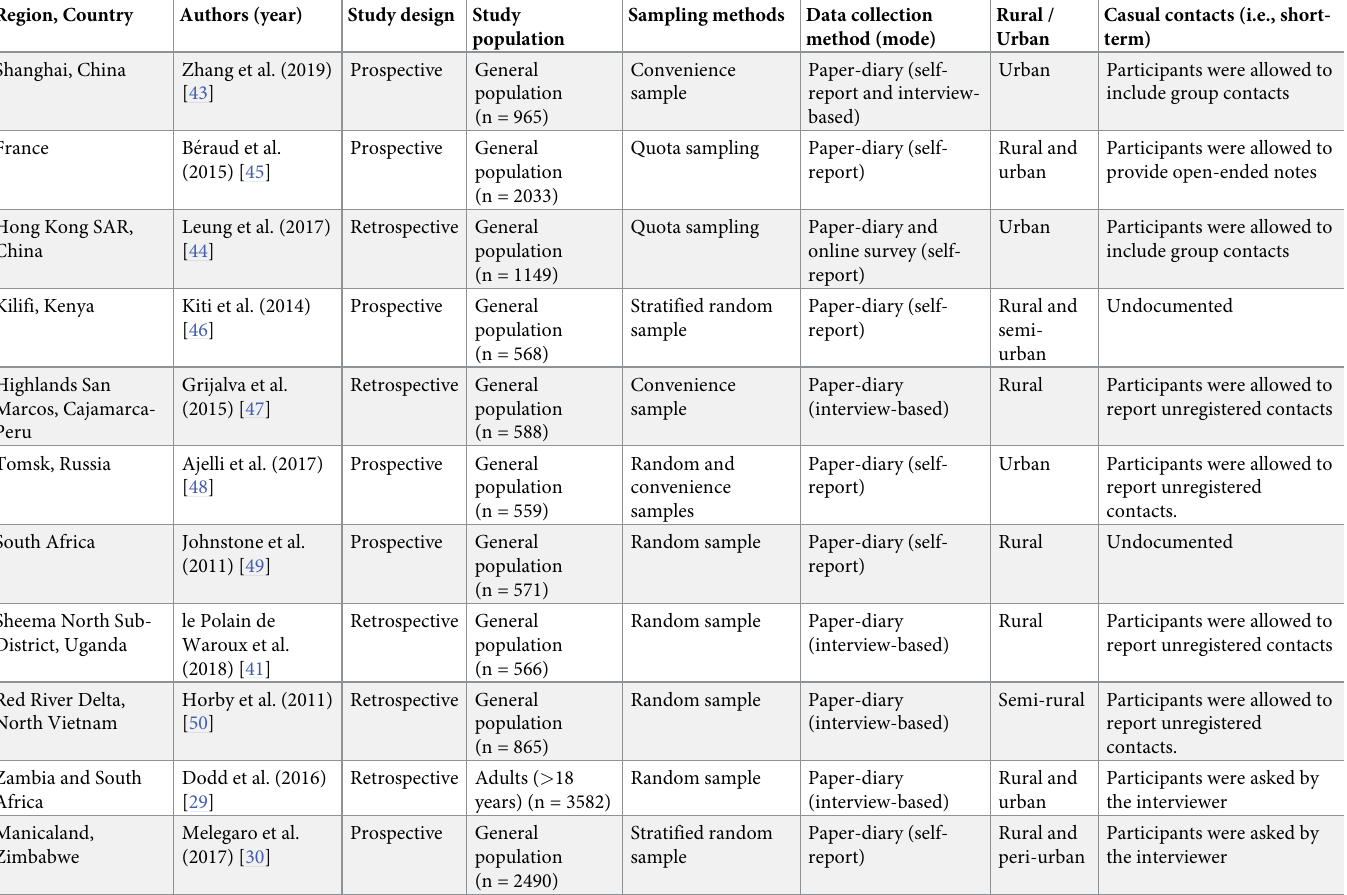
Table 2. Description of empirical contact survey studies used to construct contact matrices. Region,